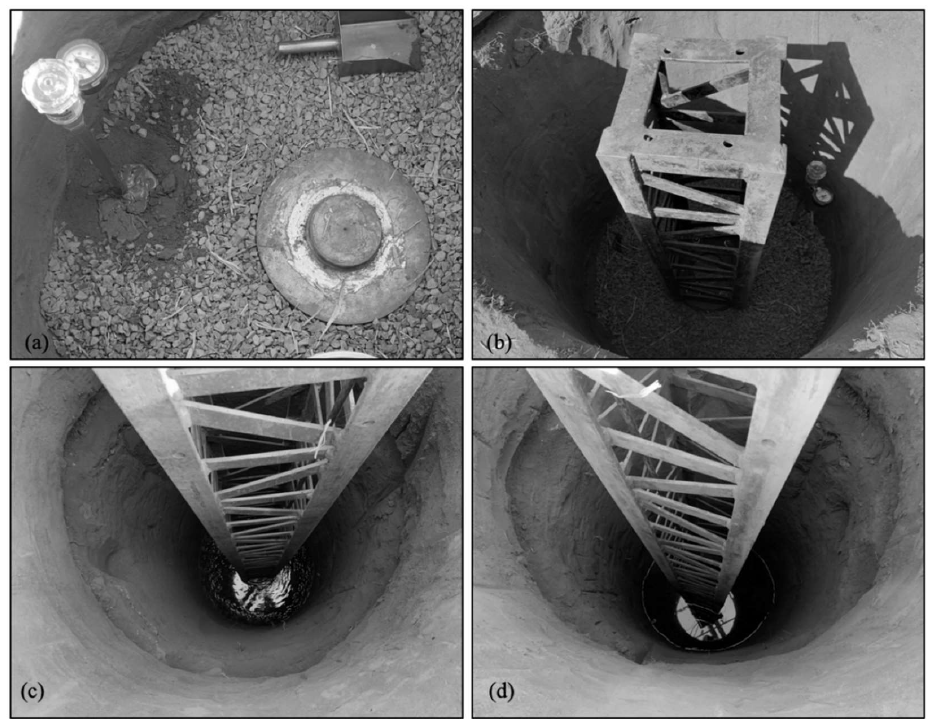
Figure 5. ( a ) Base of the pit prior to the inundation, ( b ) test assembled prior to the inundation, ( c ) process of inundation and ( d ) PLT carried out under inundated condition.